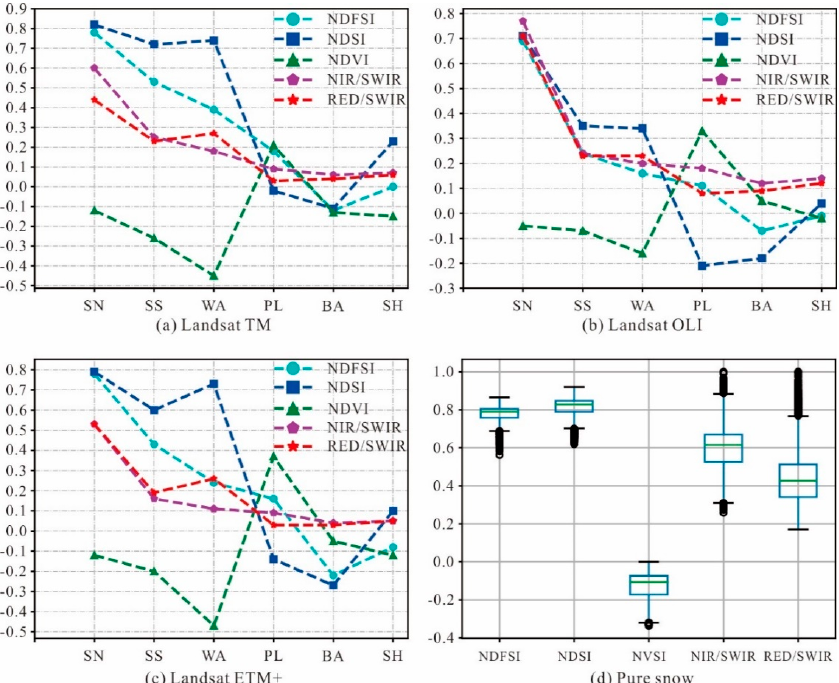
Figure 3. Line chart and box plot for different categories found in this study: ( a ) Landsat TM; ( b ) Landsat OLI; ( c ) Landsat ETM+ and ( d ) Pure snow. SN: pure snow; SS: shaded snow; WA: water; PL: plants; BA: bare land; SH: shadow. Remote Sens. 2020 , 12 , 485